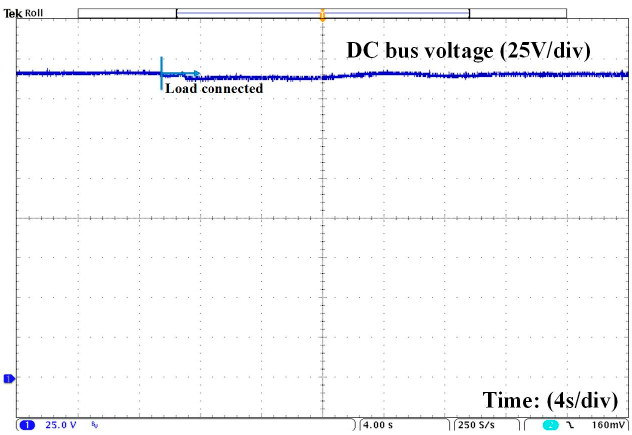
Figure 21. Connection of 400 W fluorescent lamps.